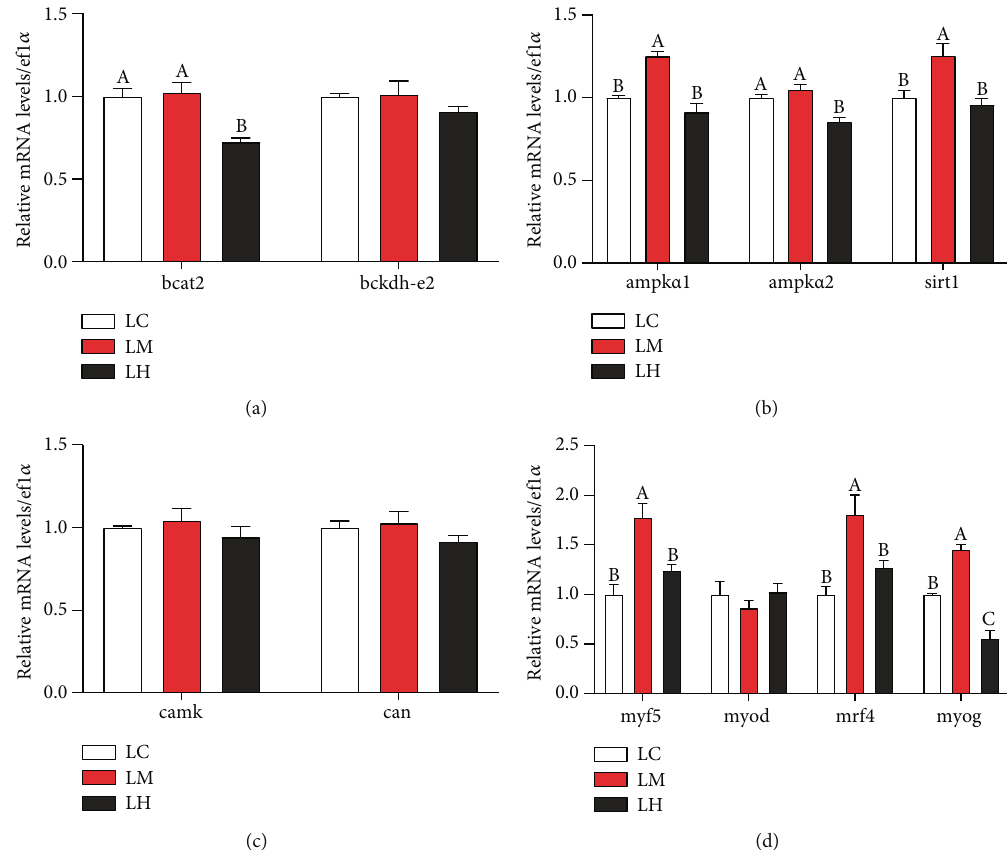
Figure 8: The transcriptional levels of genes involved in energy pathway and muscle fi ber development in blunt snout bream muscle cells cultured in the three medium of leucine levels. Branched-chain amino transferase 2 ( bcat2 ) (a); branch-chain α -keto acid dehydrogenase E2 ( bckd-e2 ) (a); AMP-activated, protein kinase α 1 ( ampk α 1 ) (b); AMP-activated protein kinase α 2 ( ampk α 2 ) (b); sirtuin 1 ( sirt1 ) (b); Calcium/ calmodulin-dependent protein kinase ( camk ) (c); Calcineurin ( can ) (c); Myostatin a ( mstna ) (d); Myostatin b ( mstnb ) (d); myogenin ( myog ) (e); myoblast determination protein ( myod ) (e); myogenic regulatory factor 4 ( mrf4 ) (e); and myogenic factor 5 ( myf5 ) (e). Values are represented as mean ± SEM ( n = 4 ) by vertical bars. Mean values with di ff erent letters indicate signi fi cantly di ff erent ( P < 0 : 05